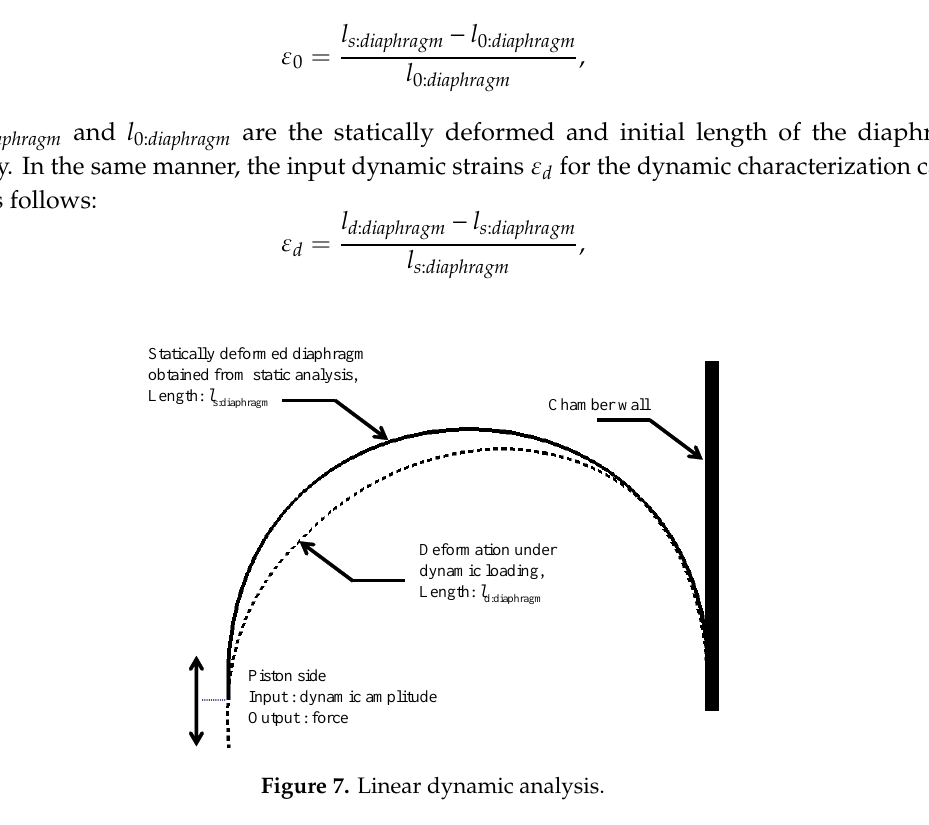
Figure 7. Linear dynamic analysis.